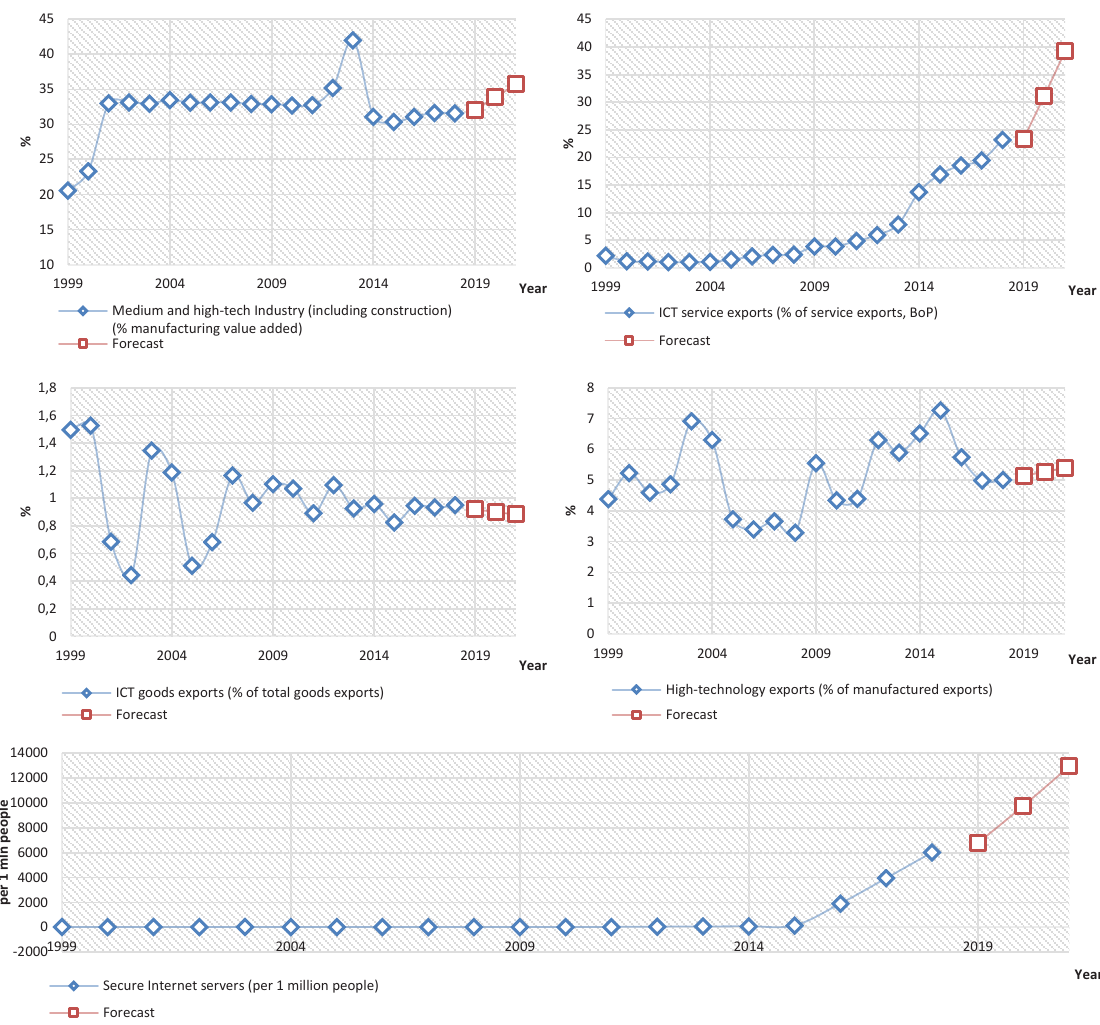
Figure 1. Graphical interpretation of retrospective and forecasted values of time series in the